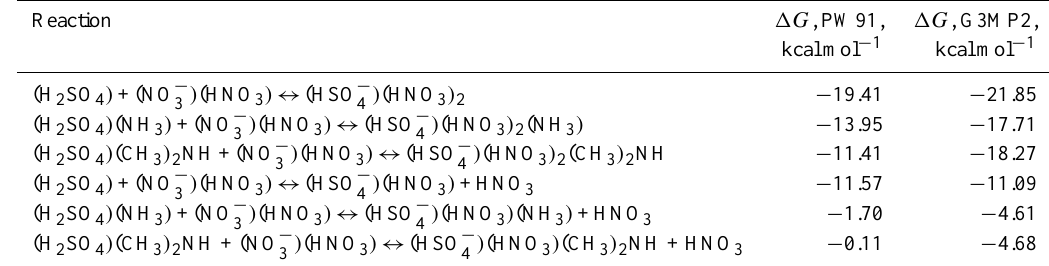
Table 4. Reaction free energies at the PW91/6-311++G(3df, 3pd) and G3MP2 levels for the clustering reactions of sulfuric acid, sulfuric acid – ammonia and sulfuric acid - dimethylamine dimers with the nitrate - nitric acid ion. All values correspond to 298K and 1atm reference pressure for all